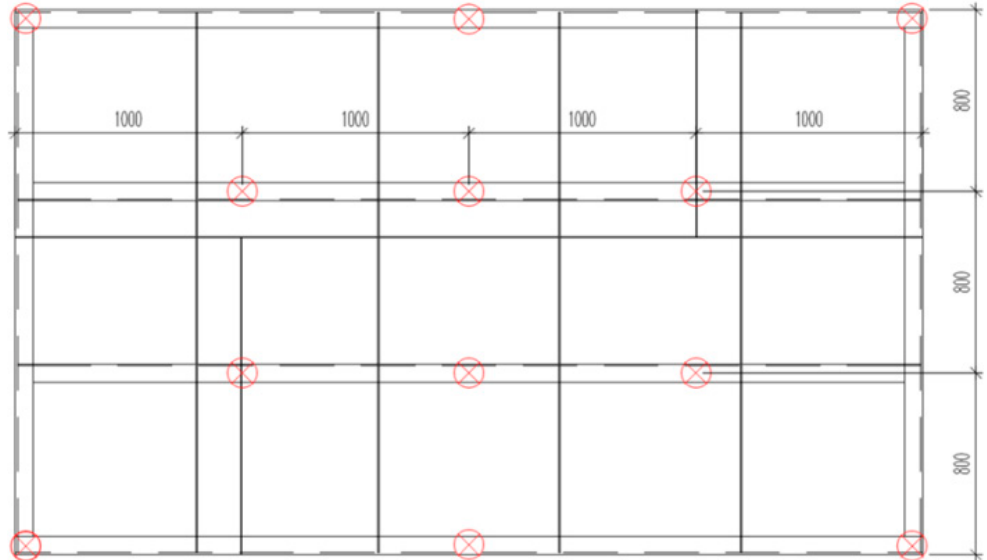
Figure 6. Diagram of the distribution of restraints in the furnace wall panel structure during welding.